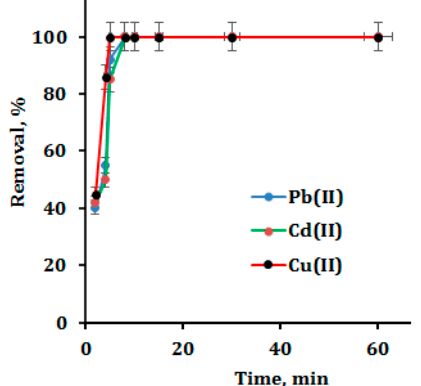
Figure 5. Effect of contact time on metal ion adsorption.